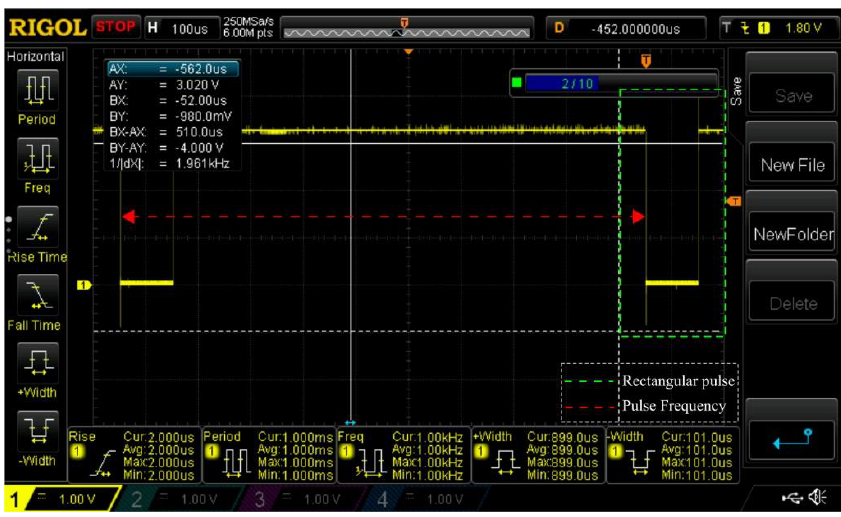
Figure 7. Oscilloscope view of EXT pulses generated at 1000 Hz by the Xnode.